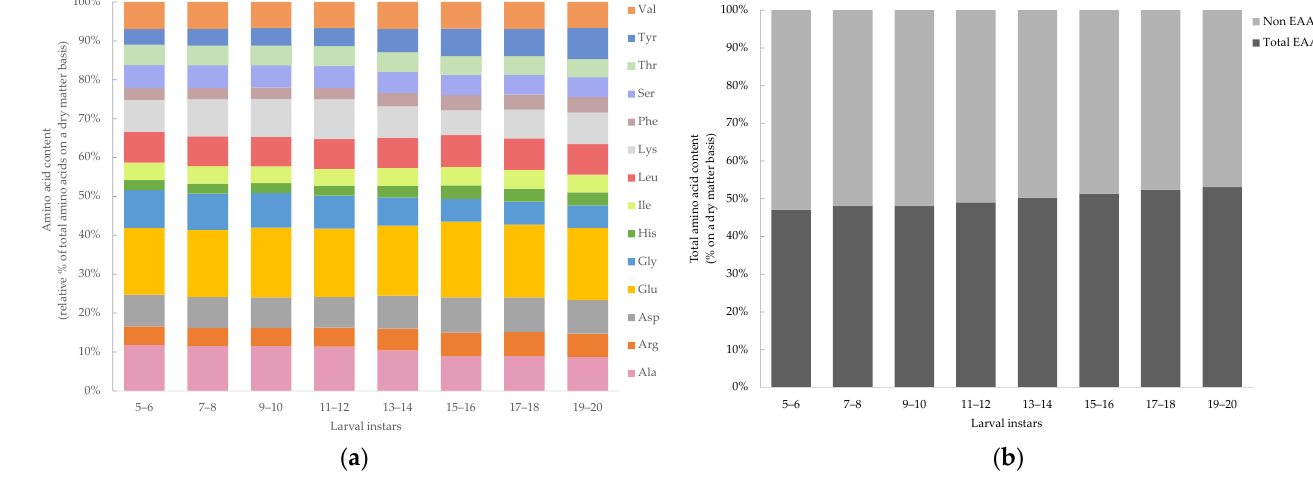
Figure 3. ( a ) Amino acid content (%) and ( b ) essential and non-essential amino acid content (%) of Tenebrio molitor larvae of different larval instars (5 to 20) on a dry matter (DM) basis analyzed by HPLC with OPA derivatization. Data are presented as mean, n = 4.